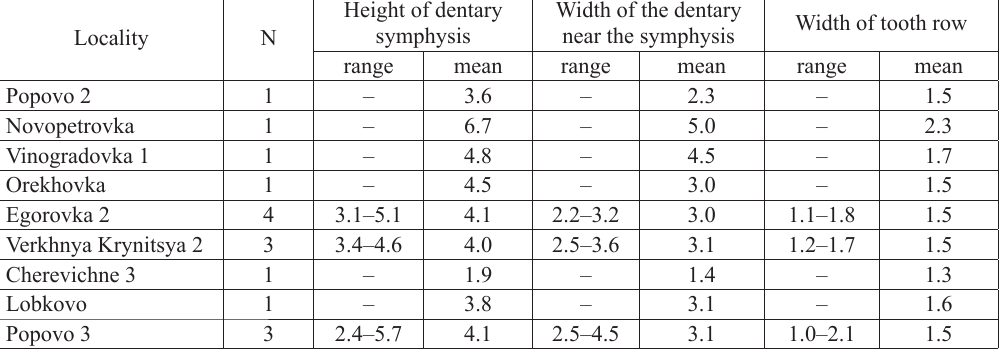
Table 2. Measurements (in mm) of dentaries of Esox sibiricus Sytchevskaya, 1974. N, number of specimens. Locality